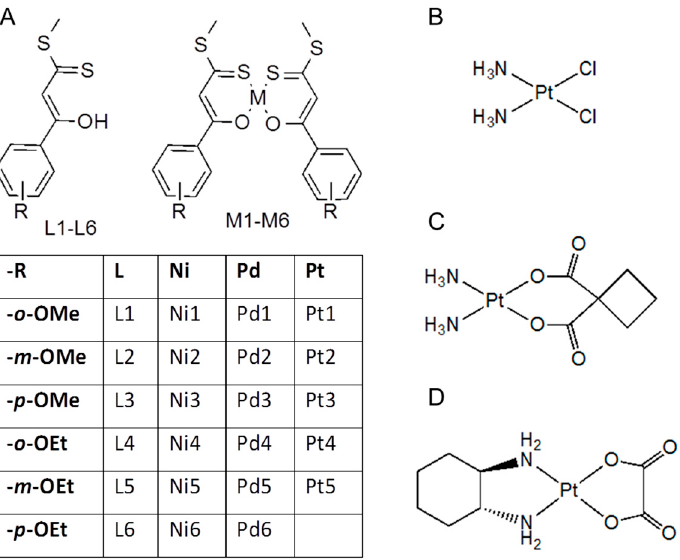
Figure 1. ( A ) Overview and substance codes of compounds used in this work: β -hydroxydithiocinnamic acid esters L1–L6 and corresponding bischelate metal complexes M1-M6 (M= Ni/Pd/Pt). Data from compound Pt6 are not included because of impurities revealed by NMR analyses. ( B – D ) Chemical structure of most commonly used platinum compounds: cisplatin ( B ), carboplatin ( C ), and oxaliplatin ( D